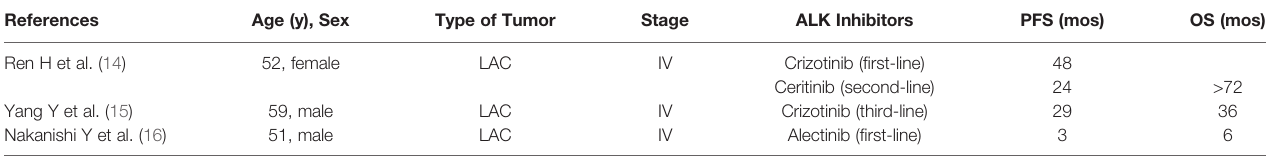
TABLE 1 | STRN-ALK fusion in patients with lung cancer in previous